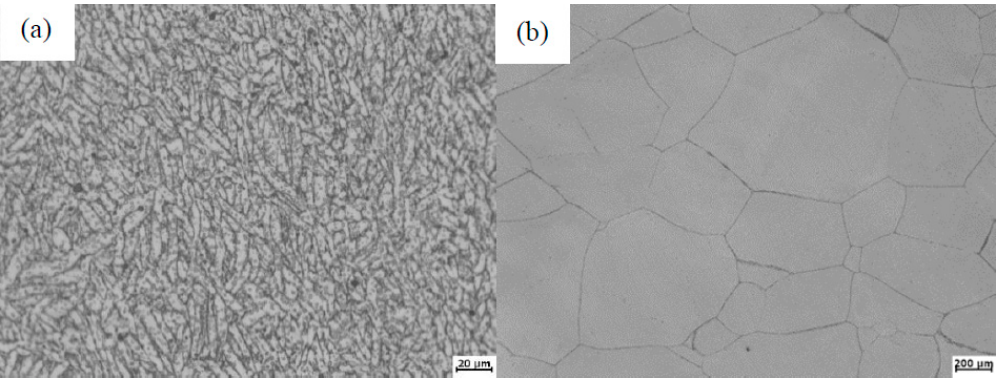
Figure 1. Microstructure of ( a ) Ti600 and ( b ) Ti-22Al-25Nb.